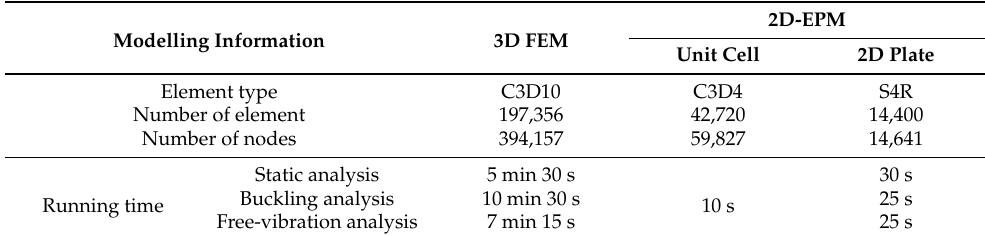
Table 4. Comparison of computational efficiency between 3D-FEM and 2D-EPM.